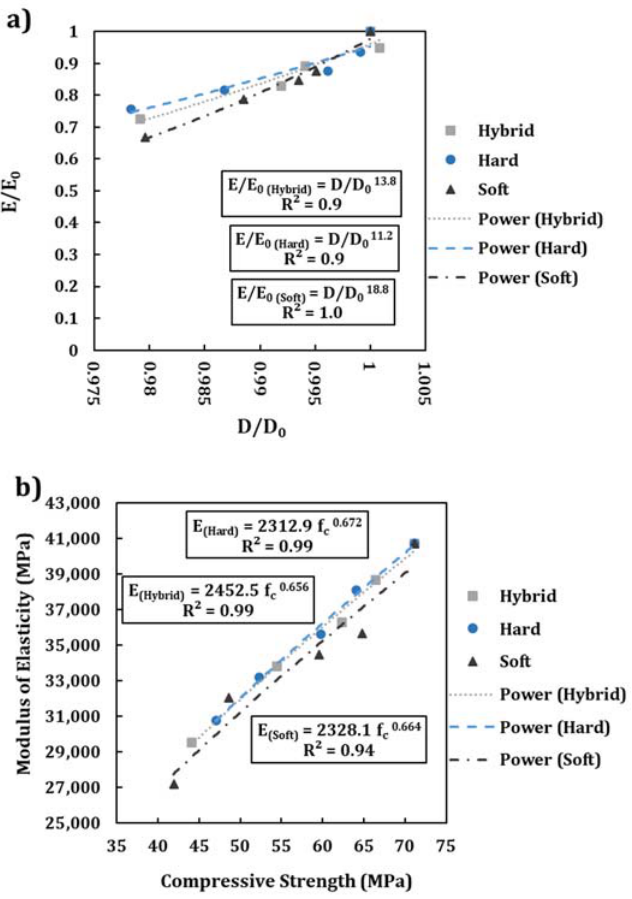
Figure 15. The modulus of elasticity ratio vs: ( a ) The density ratio of BPW-containing concrete to control concrete, ( b ) the 28-day compressive strength.